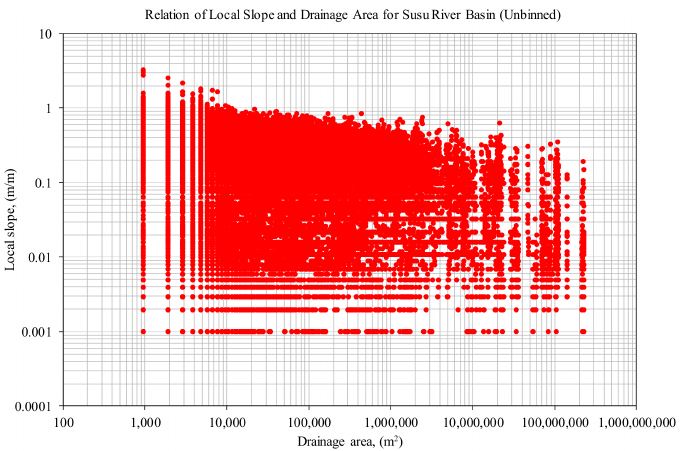
Figure 2. Relationship between local slope and drainage area for the Susu River Basin (un-binned).